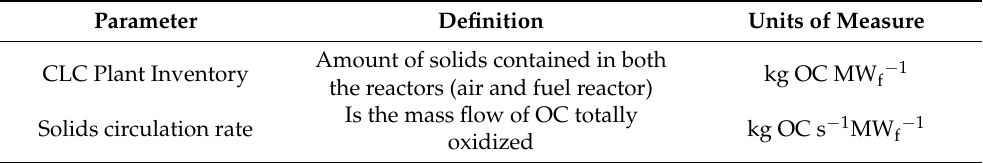
Table 2. Solids inventory and solids circulation rate units of measures and